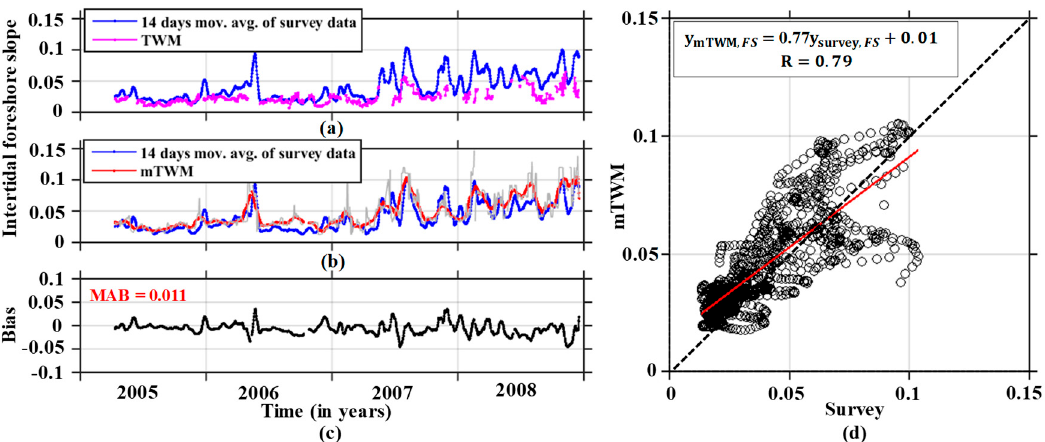
Figure 12. The temporal variations in intertidal foreshore slopes (FS) estimated from ( a ) the survey data and TWM and ( b ) the survey data and mTWM derived results (at x = − 49 m), where the off-white and red lines indicate mTWM-derived intertidal foreshore slopes and its 14-day moving average, respectively. ( c ) The bias between the survey and mTWM results. ( d ) The scatter plot of the survey vs. mTWM.